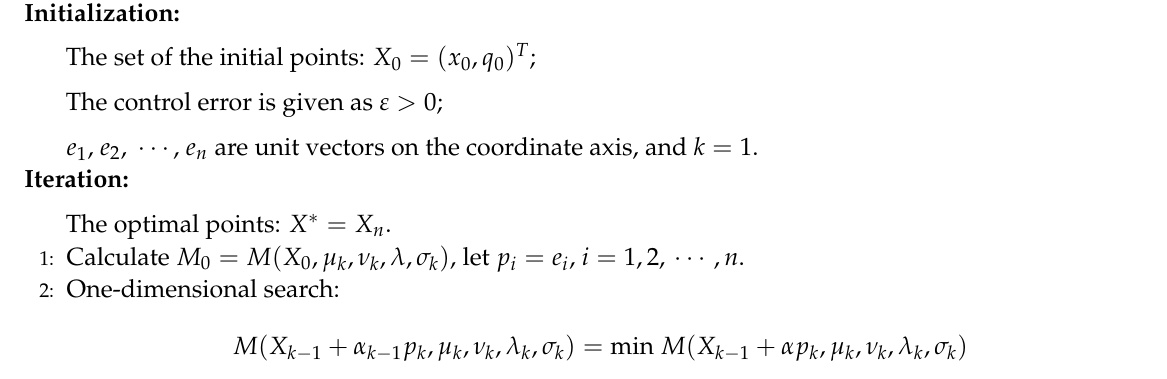
Algorithm 2 The Powell direction acceleration